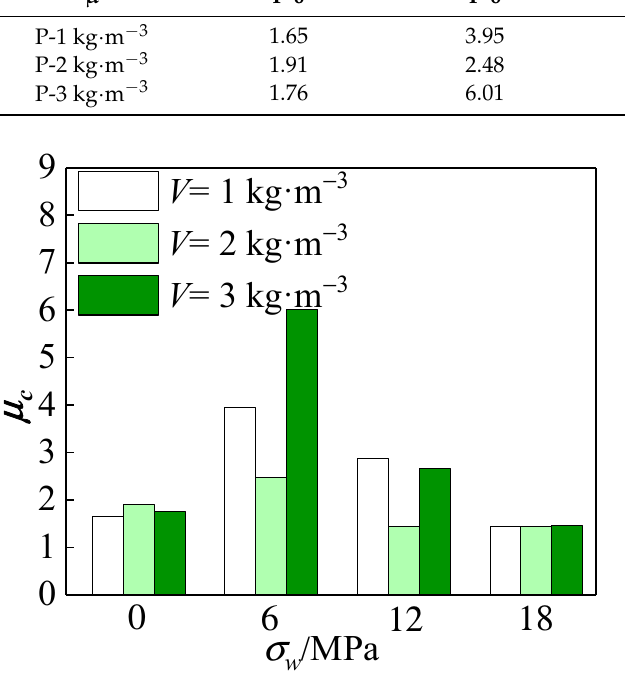
Figure 26. Relationship between ductility coefficient and confining pressure value. Table 7. Ductility factor.